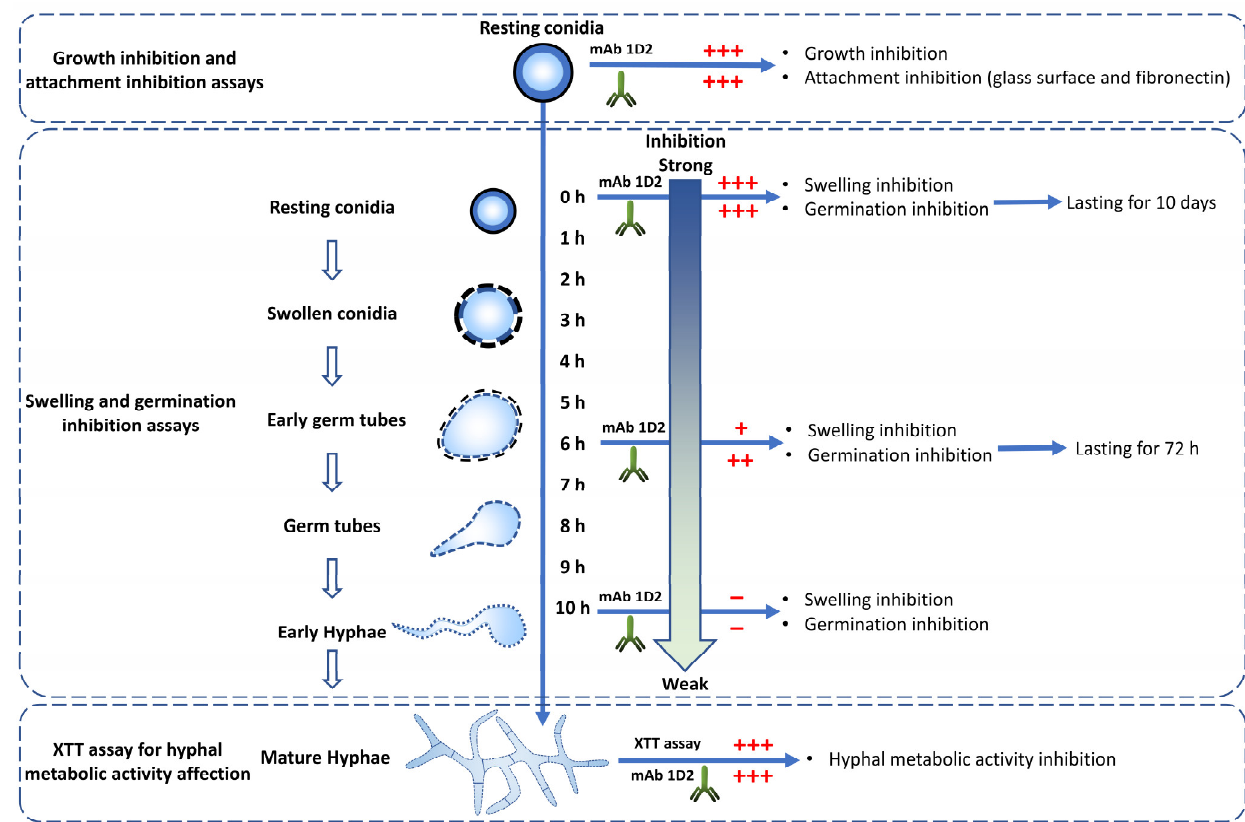
Figure 9. MAb 1D2 affects multiple important steps in the life cycle of Aspergillus species. MAb 1D2 interferes with the growth and attachment of resting conidia. In addition, it inhibits the swelling and germination of conidia. The earlier the antibody was added, the stronger the inhibition effect was. The mAb also showed damage on the filamentous hyphae metabolic activity. +++: strong inhibition; ++: moderate inhibition; +: mild inhibition; −: very weak inhibition.